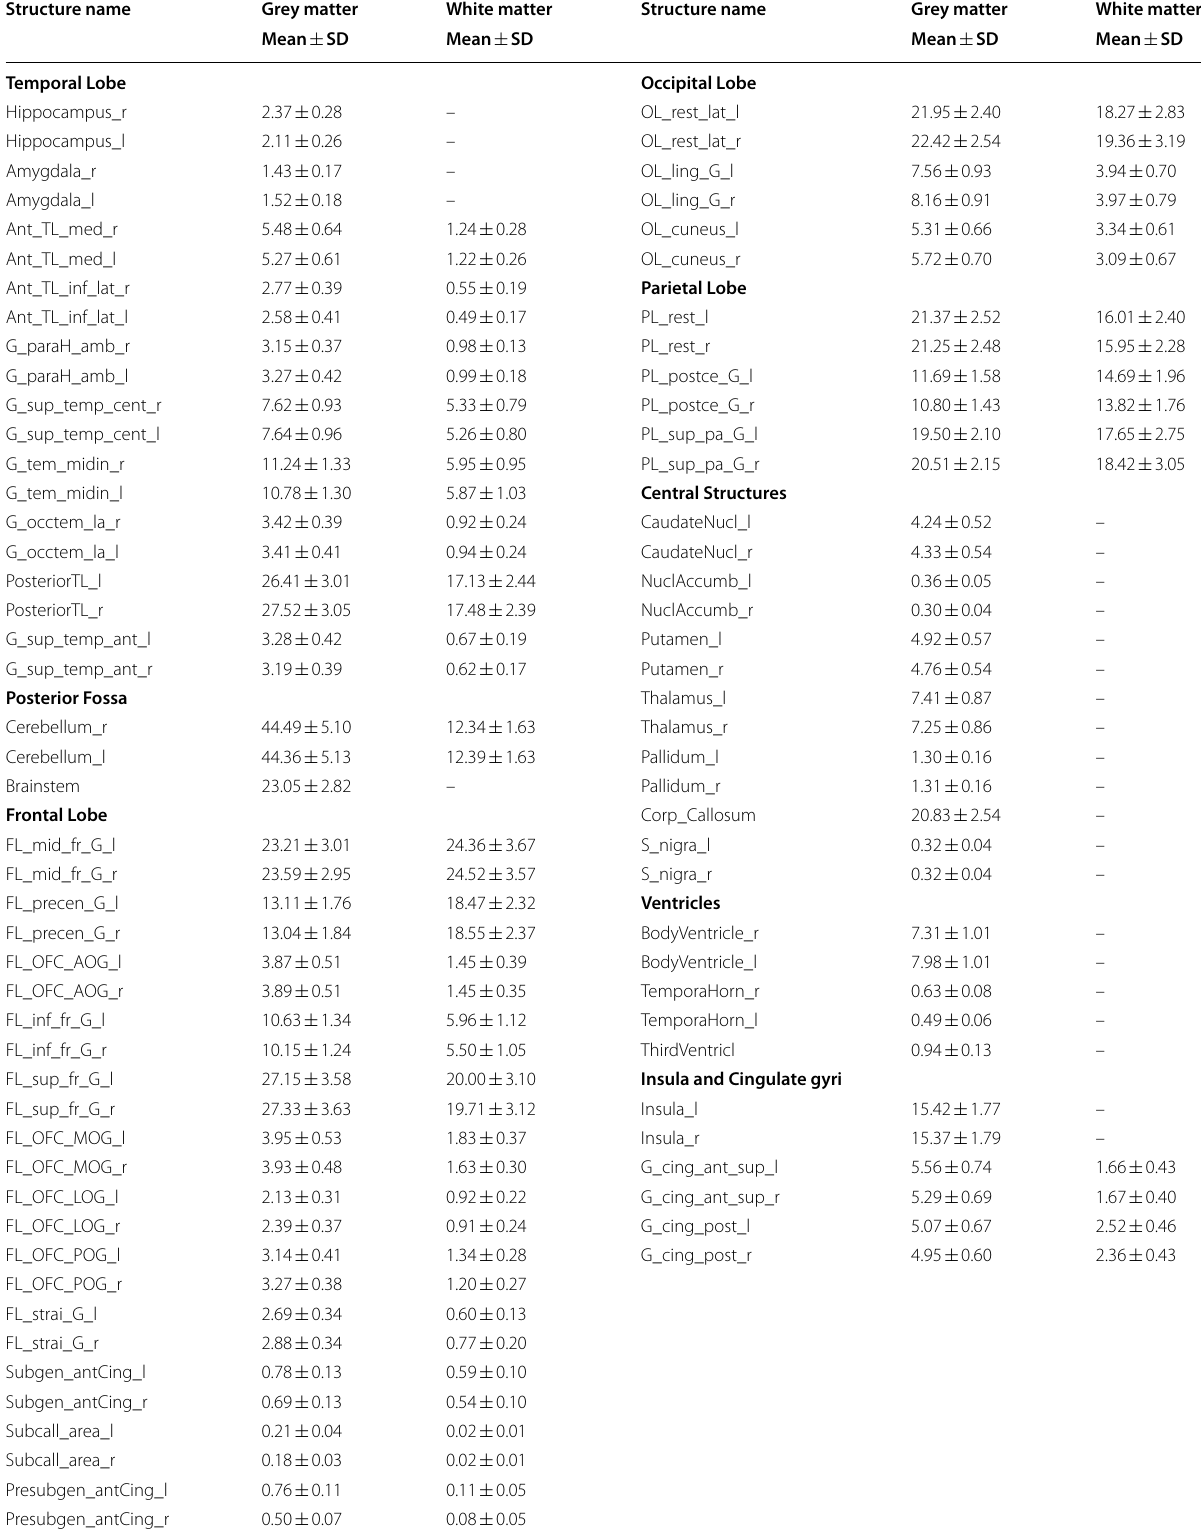
Table 2 Regional volumes in native space (in cm 3 ) Structure